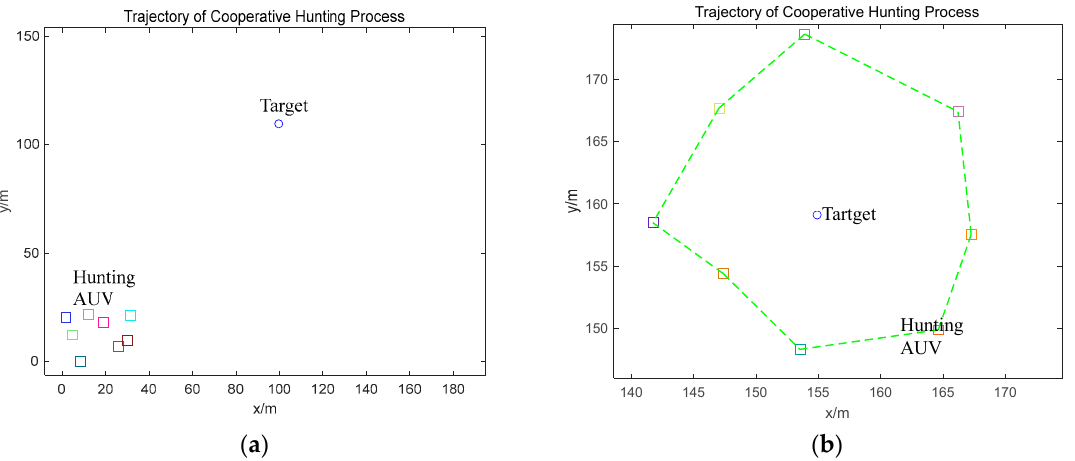
Figure 1. ( a ) The initial state of hunter AUV and the target; ( b ) termination state of the cooperative hunting task.